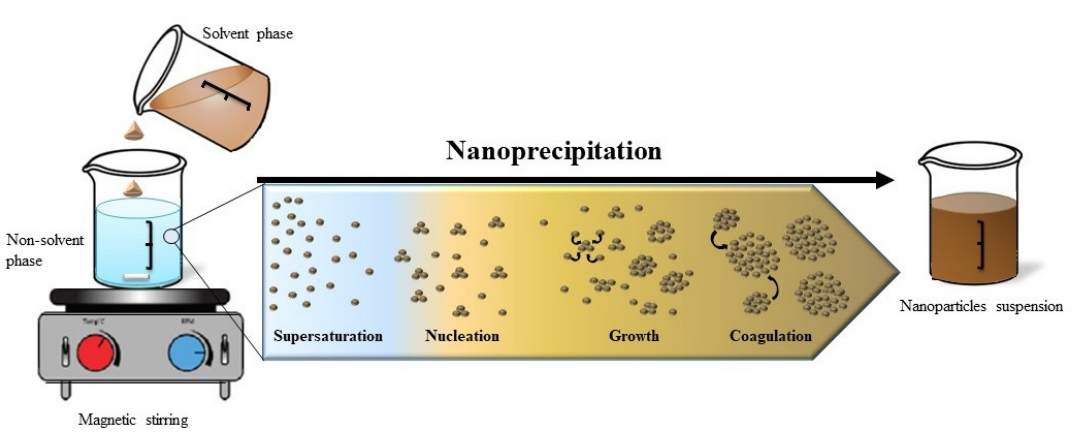
Figure 4. Illustration of the precipitation mechanism.